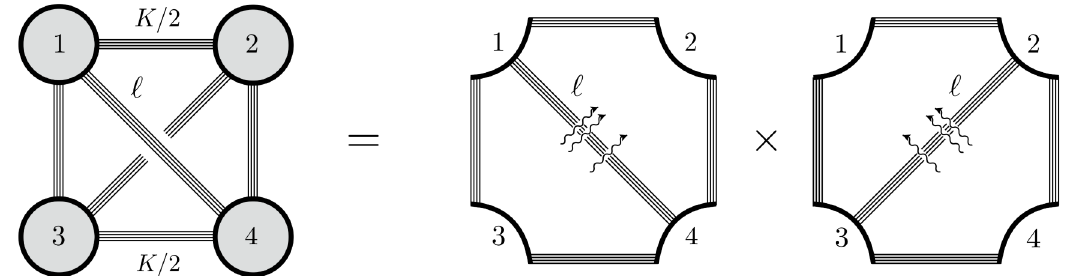
Figure 1 . Diagrammatical representation of the four-point correlation function of heavy half-BPS operators in the Born approximation (left-hand side of the equality) and at finite ’t Hooft coupling (right-hand side). The half-BPS operators are represented by the four grey blobs with exactly K outgoing lines, solid lines denote scalar propagators with the accompanying label counting their total number. The ‘simplest’ correlator corresponds to the zero length bridge ‘ = 0 , the ‘asymptotic’ one is given by the sum over ‘ ranging from 0 to K/ 2 . Factorization of the correlator into the product of two octagons is shown in the right-hand side of the equation. Each octagon describes excitations (wave lines) propagating on a world-sheet of an open string and crossing the bridge of length ‘